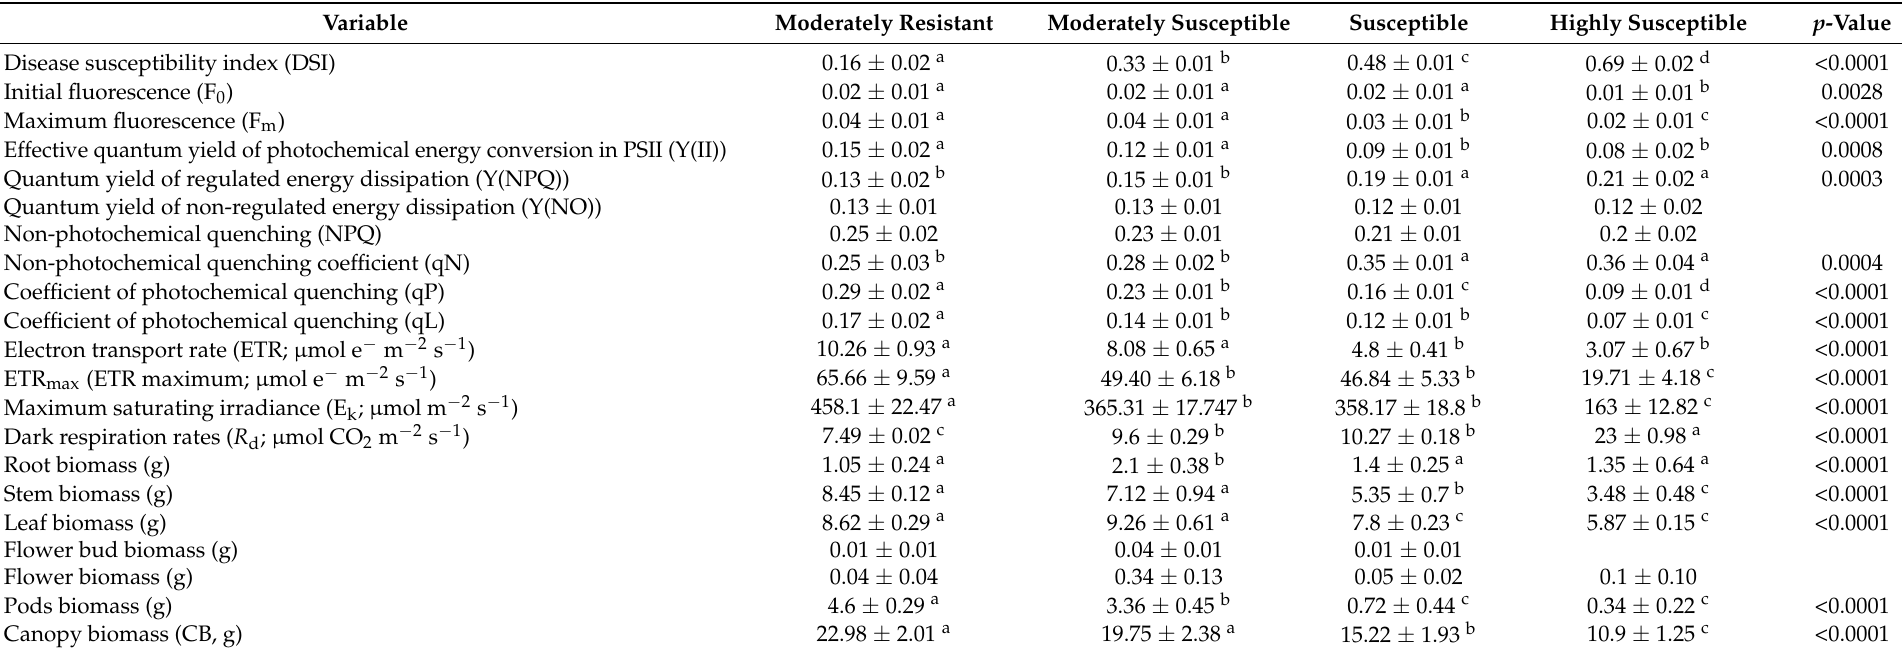
Table 1. Chlorophyll (Chl a ) fluorescence and physiological, environmental and agronomic variables of different types of common bean genotypes, classified into four groups based on the disease susceptibility index (DSI) when grown under acid soil and high temperature stress conditions in the field over two